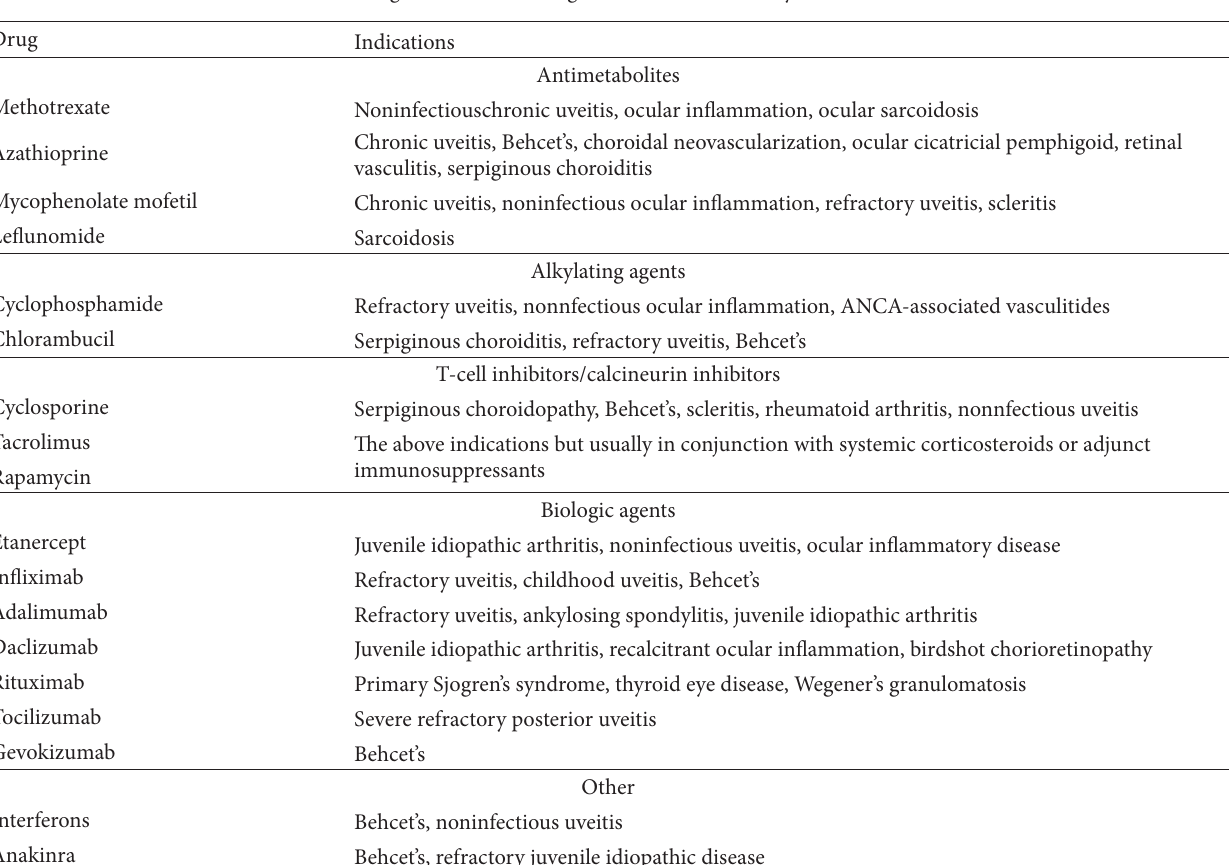
Table 3: Categories of vitritis drugs and what diseases they are indicated